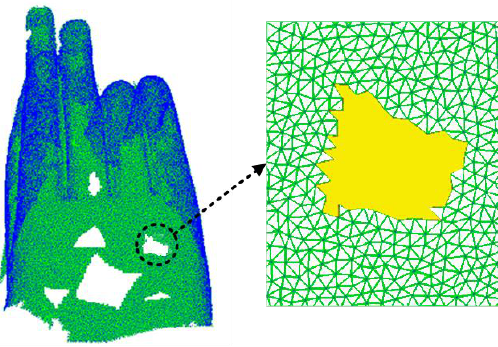
Figure 17. Automatic removal of the point cloud data, which included damage.